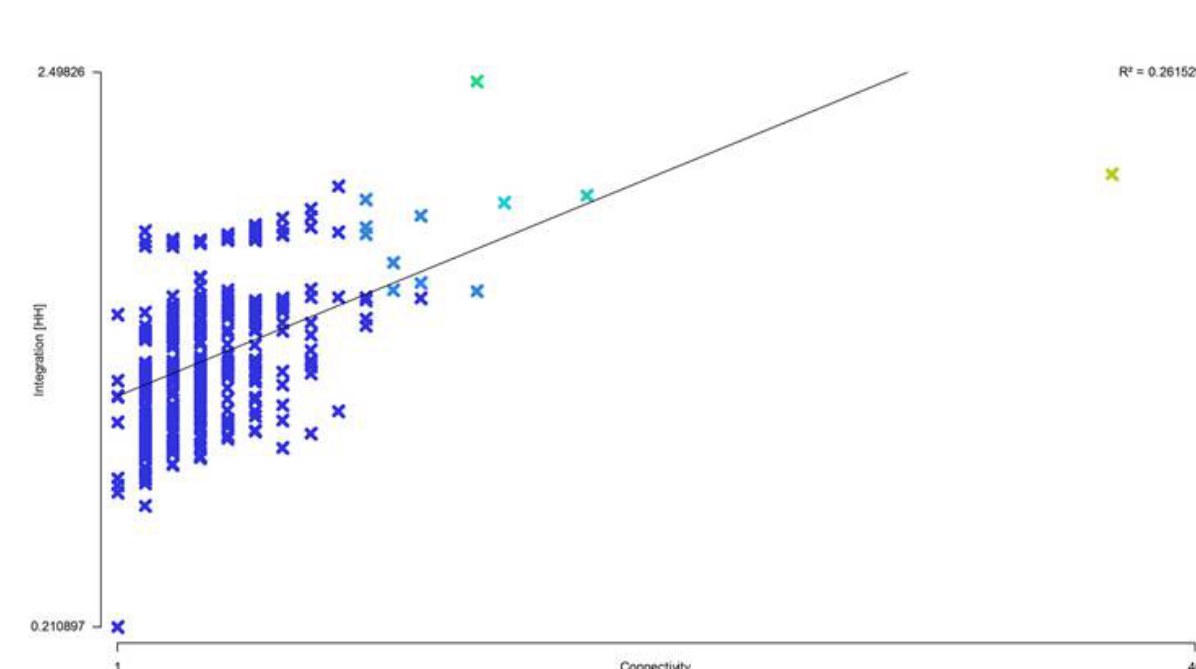
Figure 9. Scatterplot of synergy.